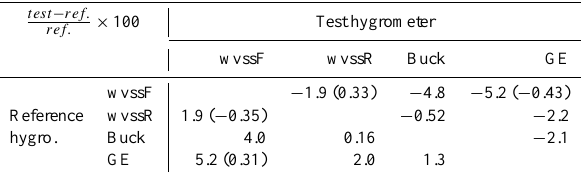
Table 1. Percentage average offsets between pairs of hygrometers. Where comparison with the new wvssF exists, the value for this is given in